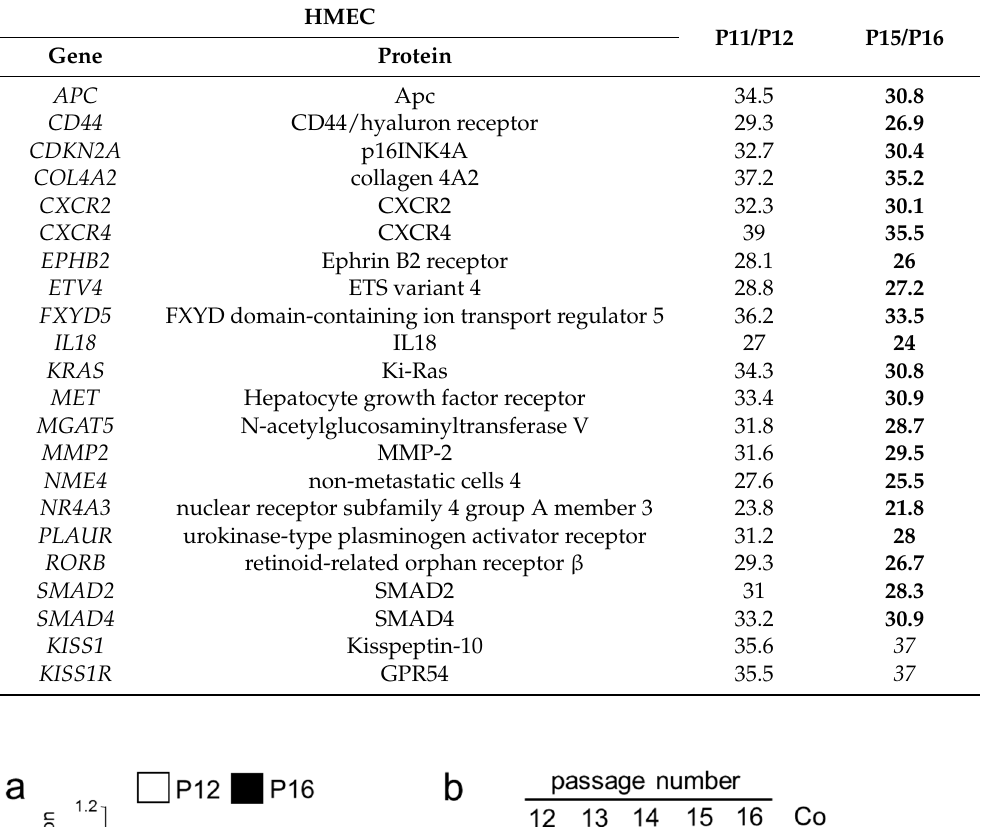
Table 1. Microarray analysis of HMEC P11/P12 vs. HMEC P15/P16 with RT 2 Profiler PCR Array Human Tumor Metastasis. List of genes with differences in Ct values >1.5 in HMEC P15/P16. Bold indicates induction, italics indicates reduction. Data are the mean of four replicates (two assays, each with two replicates).